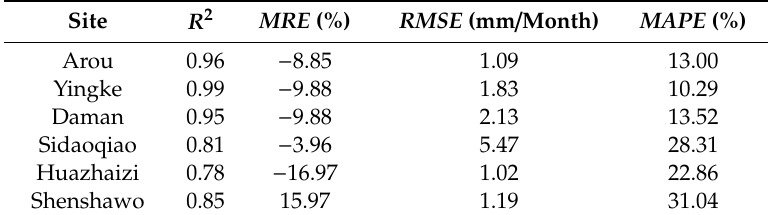
Figure 6. Observed (EC) and estimated monthly ET at 1 km resolution at the six sites from 2008 to 2014 ( a ) Arou, ( b ) Yingke, ( c ) Daman, ( d ) Sidaoqiao, ( e ) Huazhaizi, and ( f ) Shenshawo.